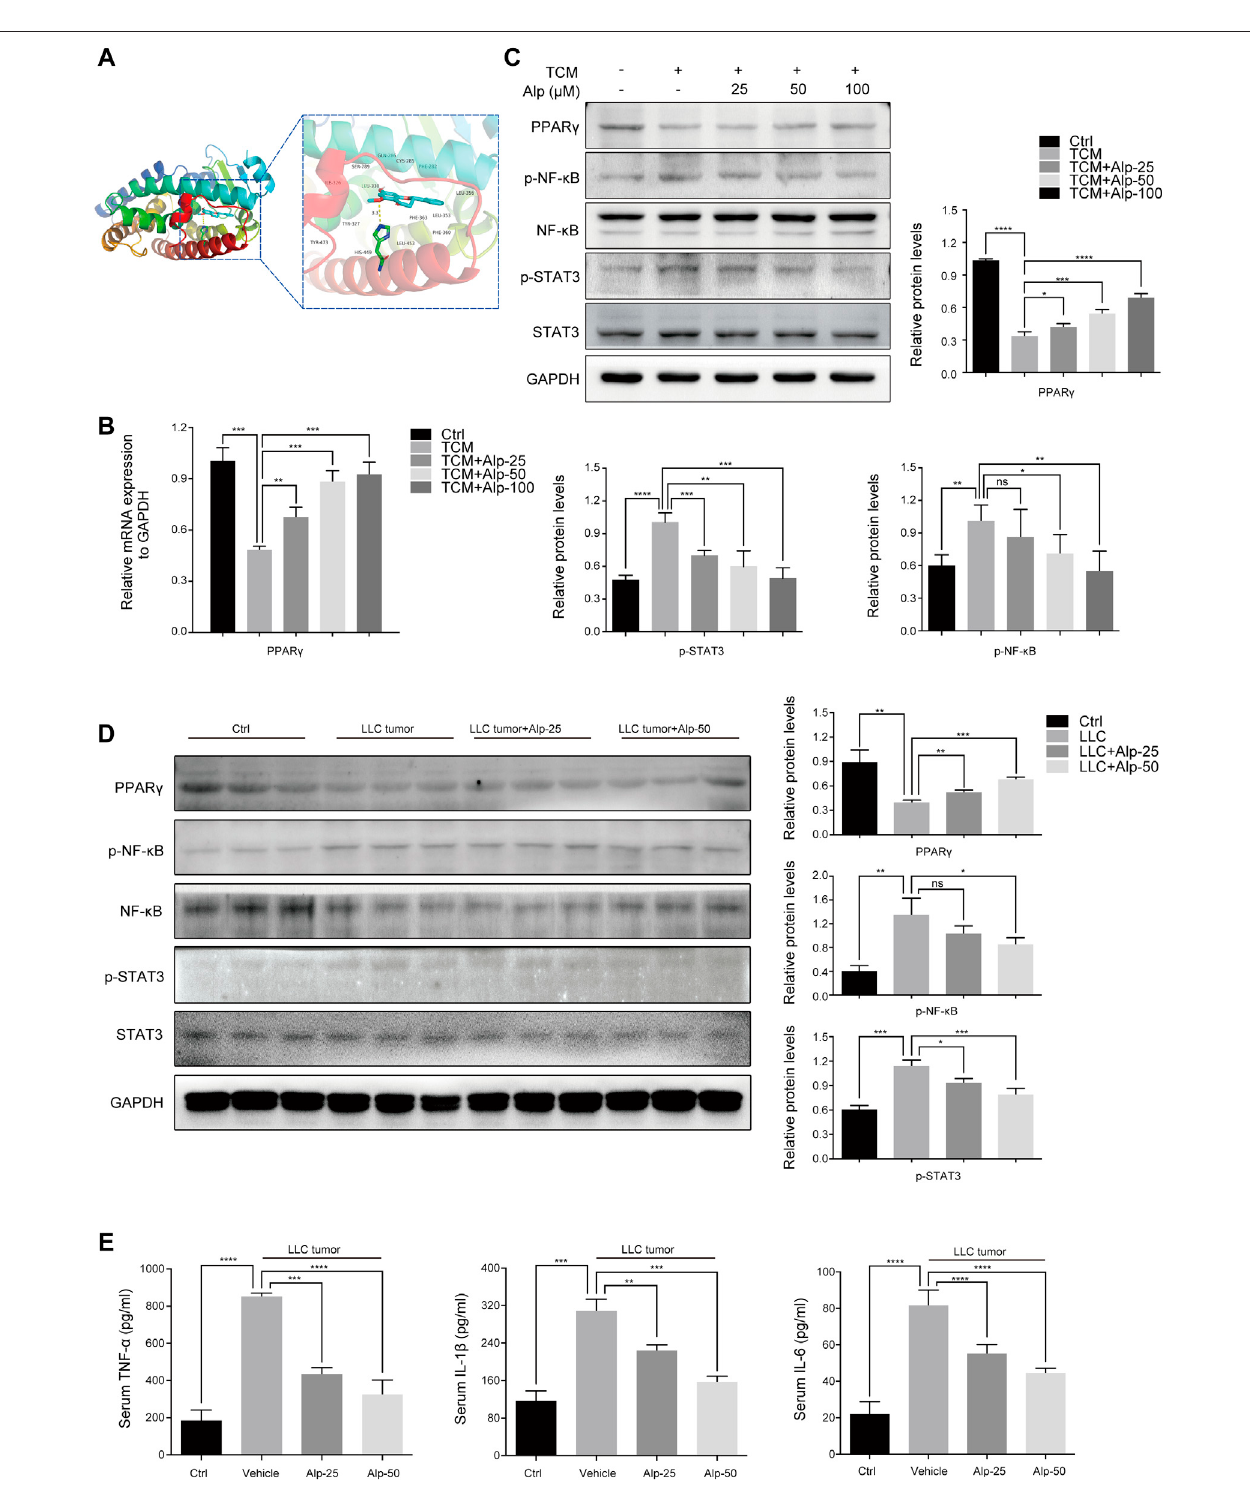
FIGURE3| AlpincreasesPPAR γ expression,inhibitsphosphorylationofSTAT3andNF- κ B,andreverseselevatedserumcytokinesinthecancercachecticmodel. (A) MoleculardockinganalysisofthebindingmodebetweenAlpandtheactivesiteofPPAR γ protein. (B) IntheC2C12myotubemodel,themRNAexpressionofPPAR γ was analyzed by real-time PCR, and (C) the indicated proteins were detected by Western blot. The band densities were quanti fi ed and normalized with GAPDH or the non-phosphorylated protein forms. (D) In the gastrocnemius muscles of the animal model, the expression levels of indicated proteins were examined by Western blot, and the densities were quanti fi ed and normalized with GAPDH or the non-phosphorylated protein forms. (E) Pro-in fl ammatory cytokines of TNF- α , IL-1 β , and IL-6 were analyzed by ELISA in the serum of the cachexia mice model. * p < 0.05, ** p < 0.01, *** p < 0.001, **** p < 0.0001 vs. control. ns: not signi fi cant. n (cid:1) 3.